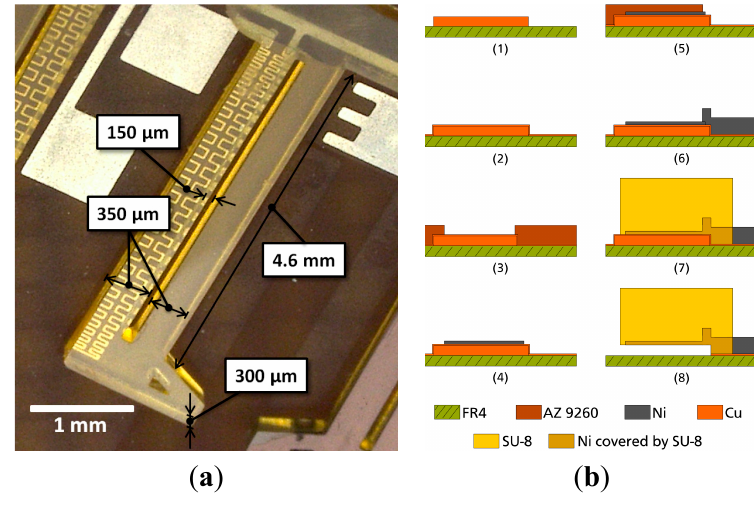
temperature gradient between the outer and the inner beam, homogeneous heating of the whole system (e.g., rise of room temperature) does not lead to actuator deflection. Figure 1. Polymer electrothermal pseudo-bimorph actuator: ( a ) Fabricated pseudo bimorph actuator with typical dimensions [17]. ( b ) Fabrication process: (1) Sacrificial layer: Structuring 15 μ m of laminated copper using wet etching. (2) Conductive seed layer: Sputtering of 200 nm Cu for electroforming. (3) Heater I: Structuring the mold using 10 μ m of AZ 9260. (4) Heater II: Electroforming of 2 μ m Ni. (5) Conducting paths I: Structuring the mold using 30 μ m of AZ 9260. (6) Conducting paths II: Electroforming of 20 μ m Ni. (7) Expansion body: Structuring of 300 μ m SU-8 2025 using UV-lithography. (8) Release: Wet etching of